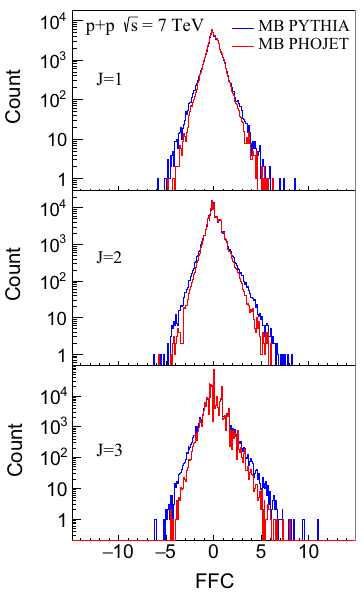
Fig. 6 Strength ( ξ ) vs. fraction of jet events mixed in MB sample in √ s = 7TeV from MC truth and Digits pp collisions at